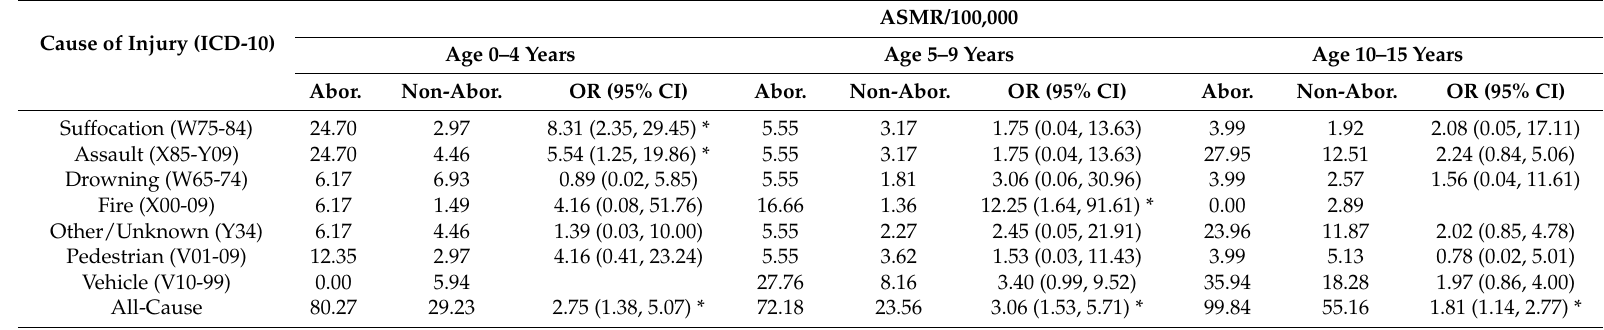
Table 3. Age- and mechanism-specific mortality rates (per 100,000) with odds ratios and 95% CI for decedent age groups 0–4, 5–9, and 10–15 years. Asterisks indicate statistically significant odds ratios.